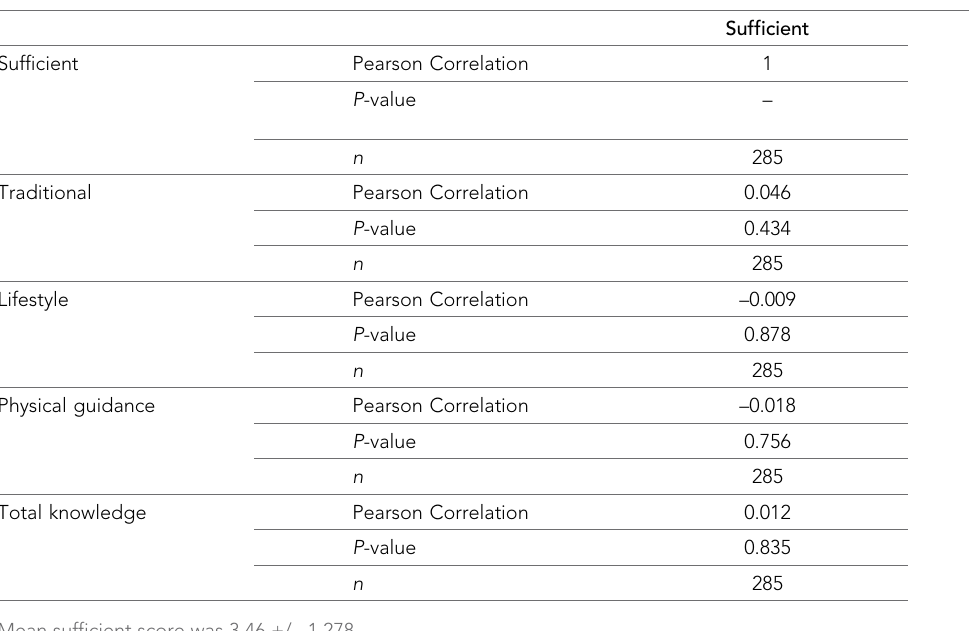
Table 6. Pearson correlations between perceived sufficiency of exercise and knowledge of physical activities